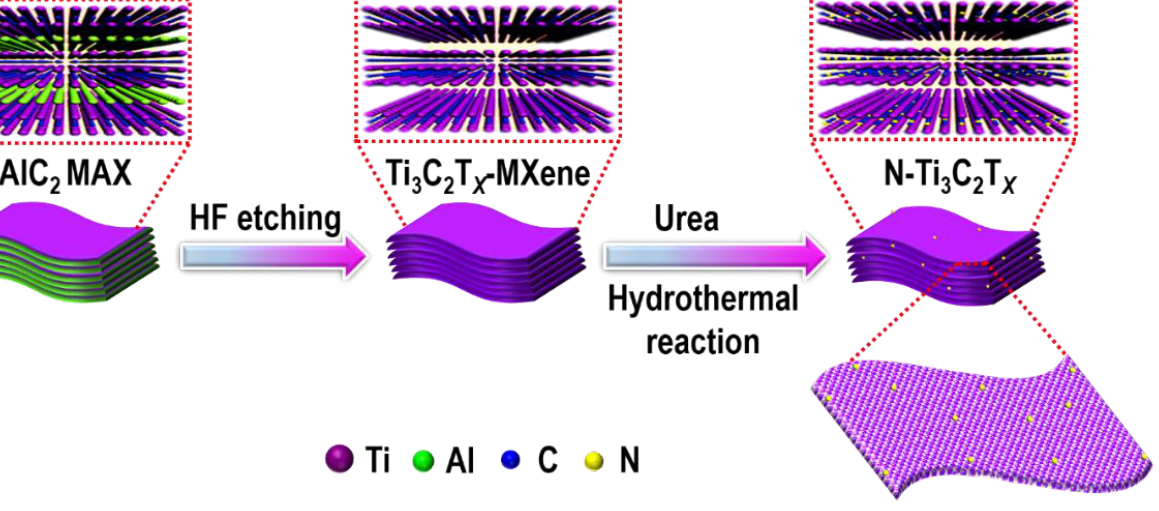
Figure 1. A schematic diagram of N -Ti 3 C 2 T x - MXene’s